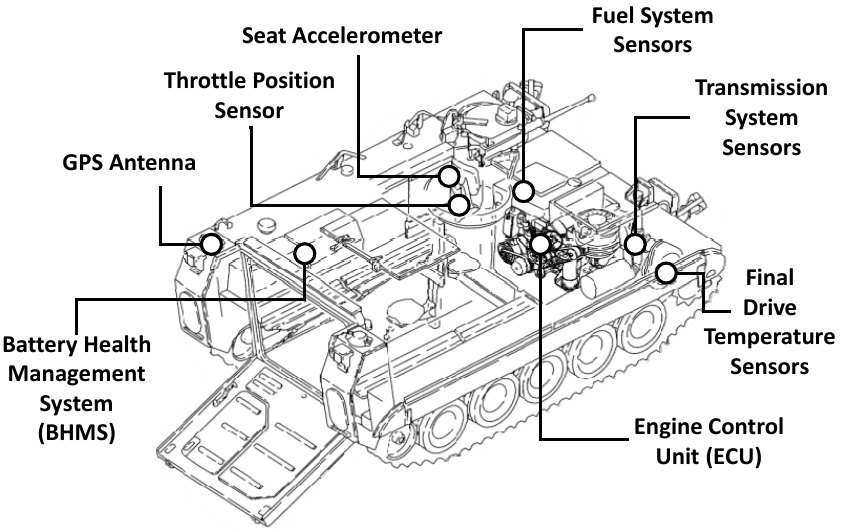
Figure 2. Armoured personnel carrier (APC) fitted with HUMS sensor network.